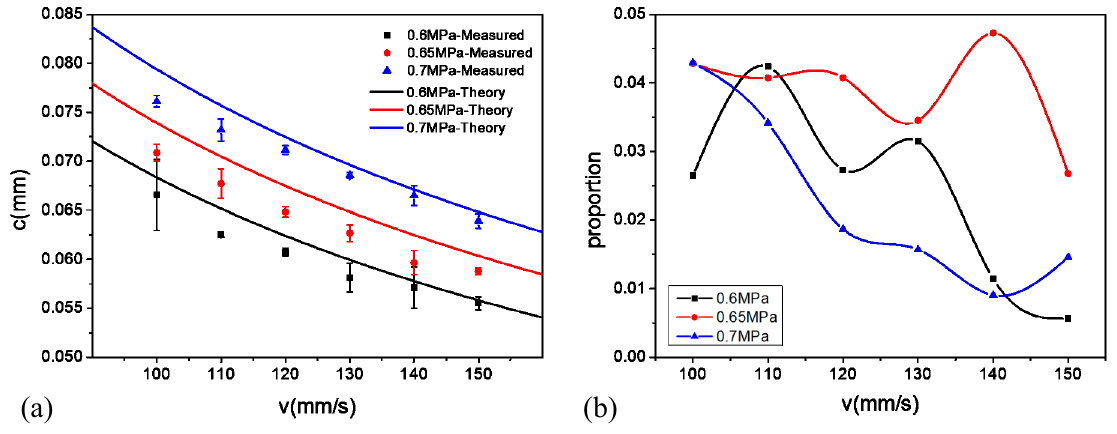
Figure 8. ( a ) Comparison of the experimental and theoretical results. ( b ) Error variation between the theoretical and experimental values.